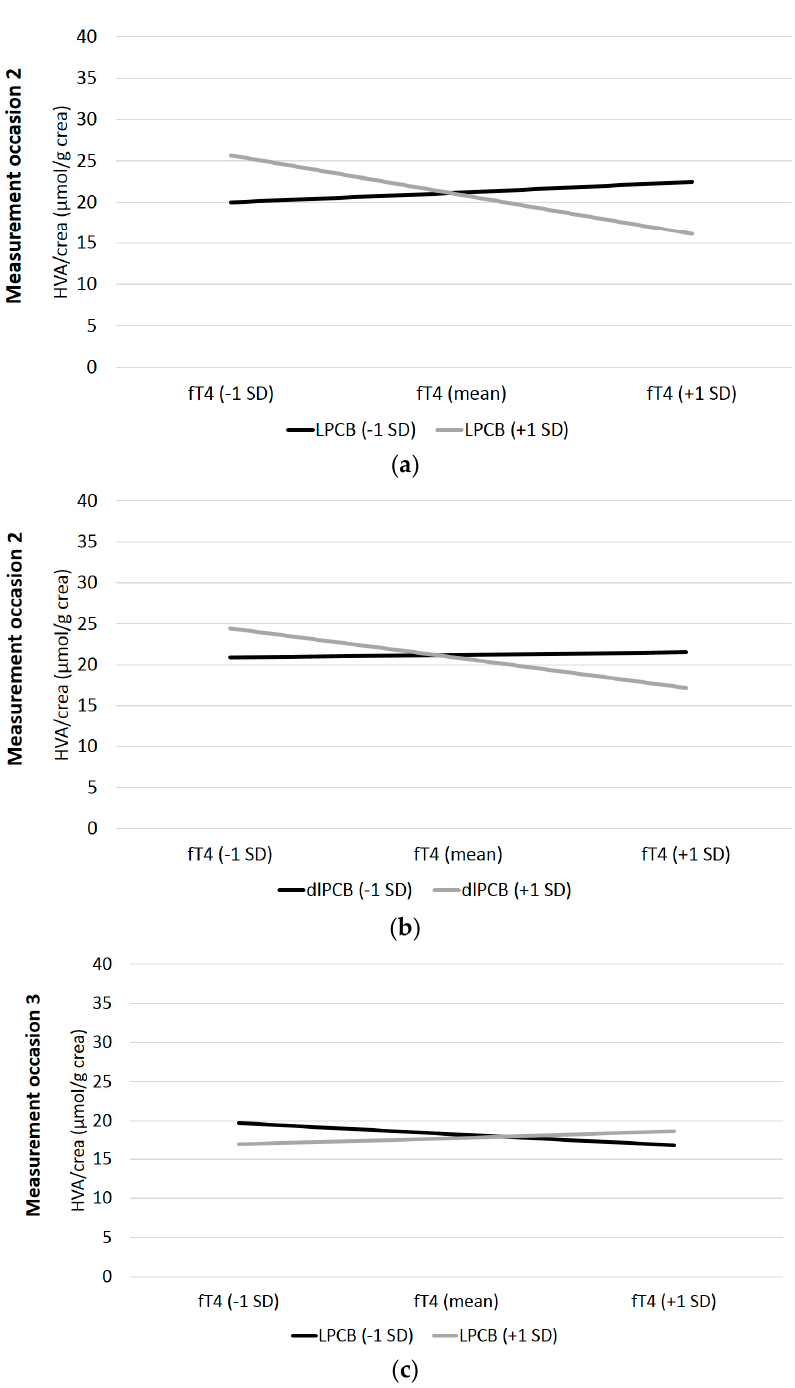
interaction of LPCBs on the association between fT4 and HVA/crea, so hypothesis one can only be partially confirmed. interaction terms are in bold.